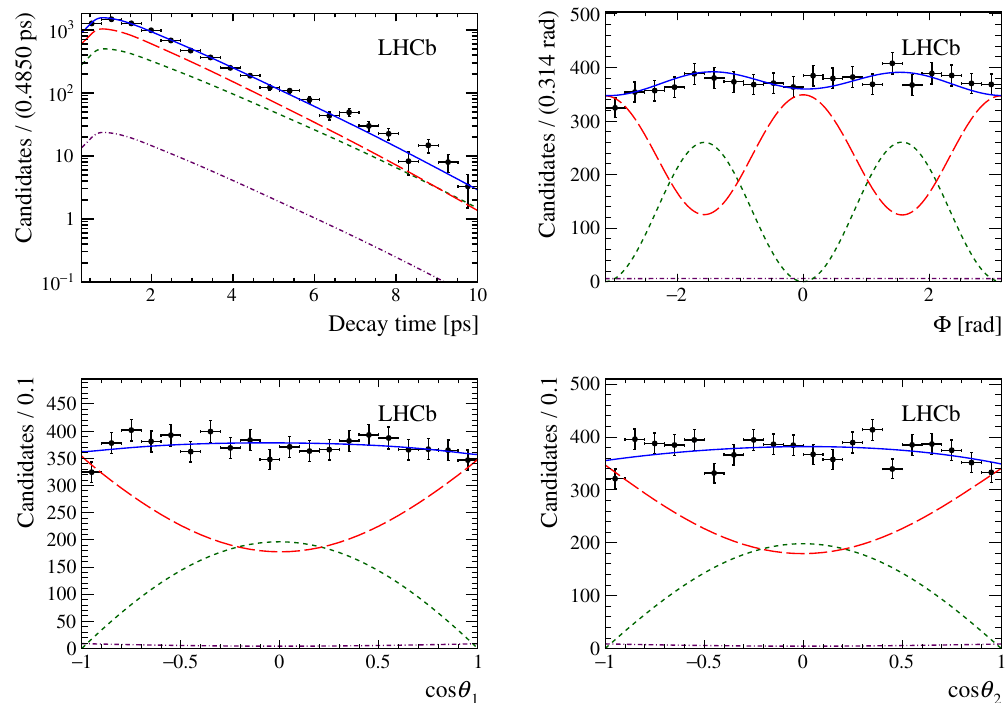
Figure 5 . One-dimensional projections of the B 0 ! (cid:30)(cid:30) (cid:12)t for (top-left) decay time with binned s acceptance, (top-right) helicity angle (cid:8) and (bottom-left and bottom-right) cosine of the helicity angles (cid:18) 1 and (cid:18) 2 . The background-subtracted data are marked as black points, while the blue solid lines represent the projections of the (cid:12)t. The CP -even P -wave, the CP -odd P -wave and the combined S -wave and double S -wave components are shown by the red long dashed, green short dashed and purple dot-dashed lines, respectively. Fitted components are plotted taking into account e(cid:14)ciencies in the time and angular